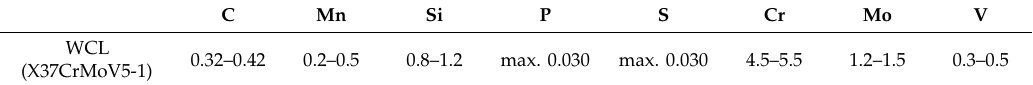
Table 6. Chemical composition of X37CrMoV5-1 steel according to ISO 4957:2018 standard [44].